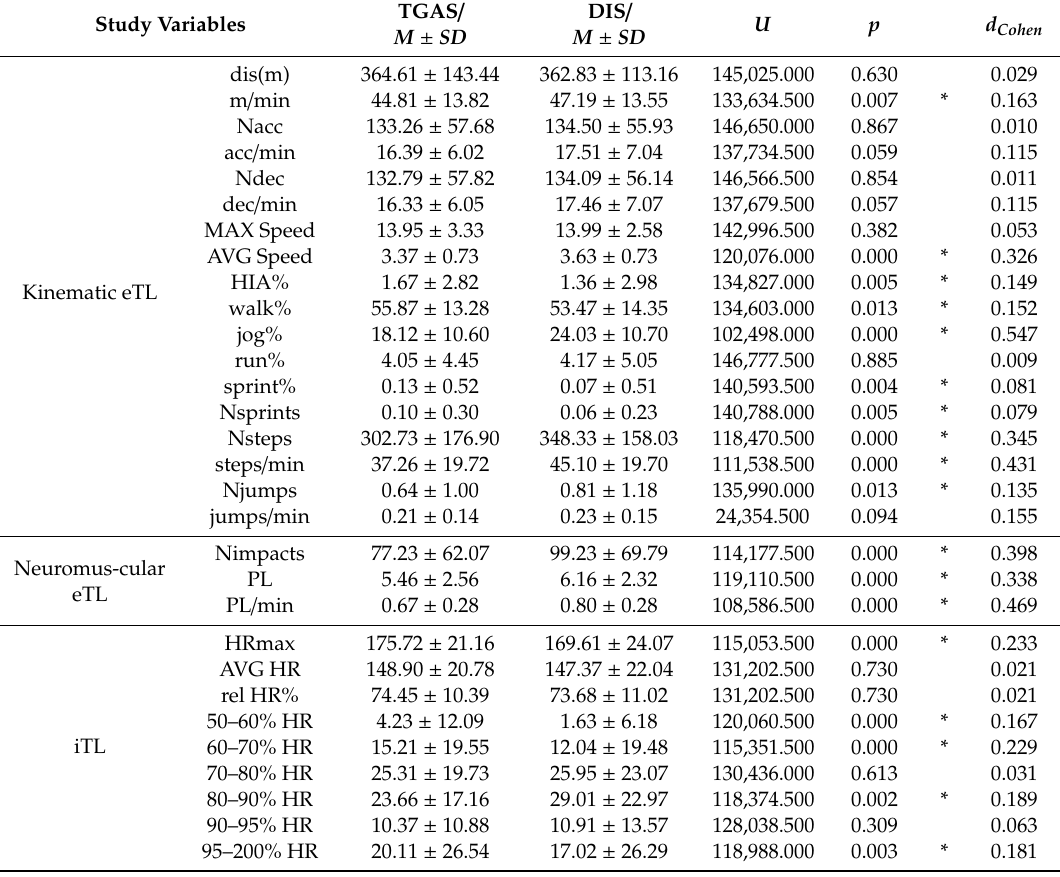
Table 2. Results of the application of the programs according to the teaching methodology.